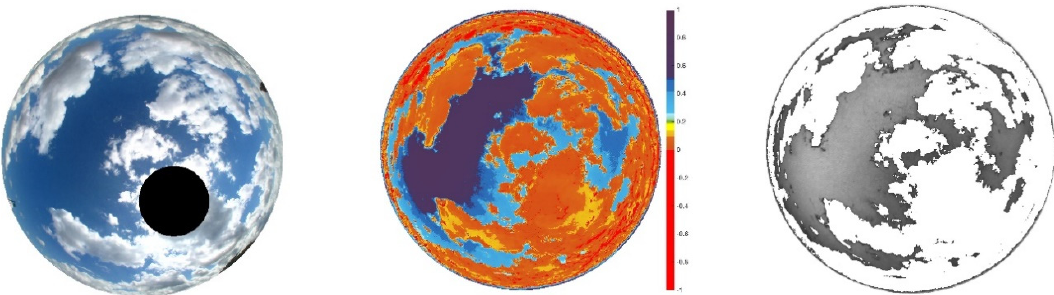
Figure 2. Automatic segmentation of a picture taken on 22 June 2014 at 12:53. The first column shows the original image. The results of the haze index algorithm can be seen in the second column. The third column shows the two classes: cloud clusters in white and sky clusters in gray.